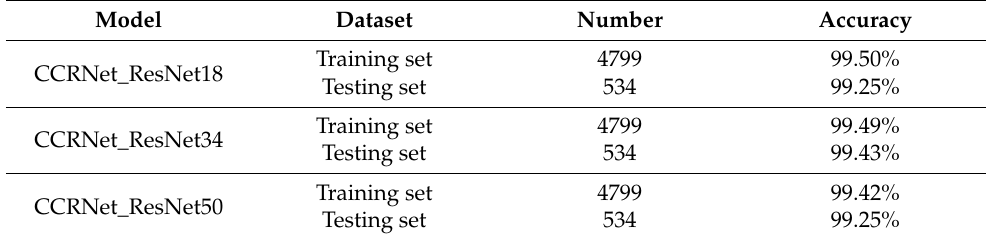
Table 3. The accuracy of ResNet for character recognition on the training set and testing set.